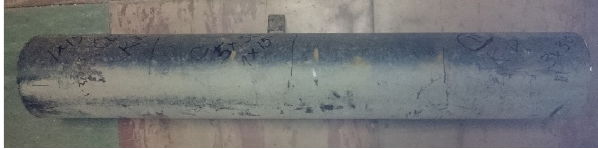
Figure 21. Tested middle part of axel.